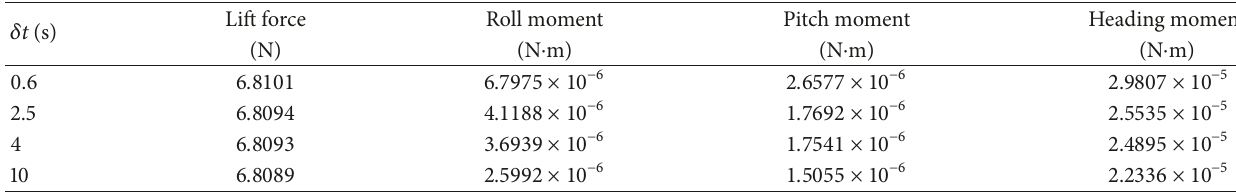
Table 12: Comparison results of induced